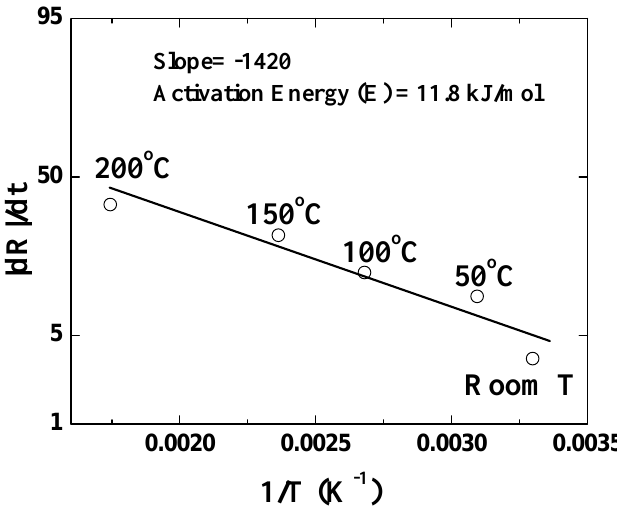
Figure 5. Time dependence of resistance change of Pd-coated multiple ZnO nanorods as the gas ambient is switched from N (10-500 ppm) and then back to N